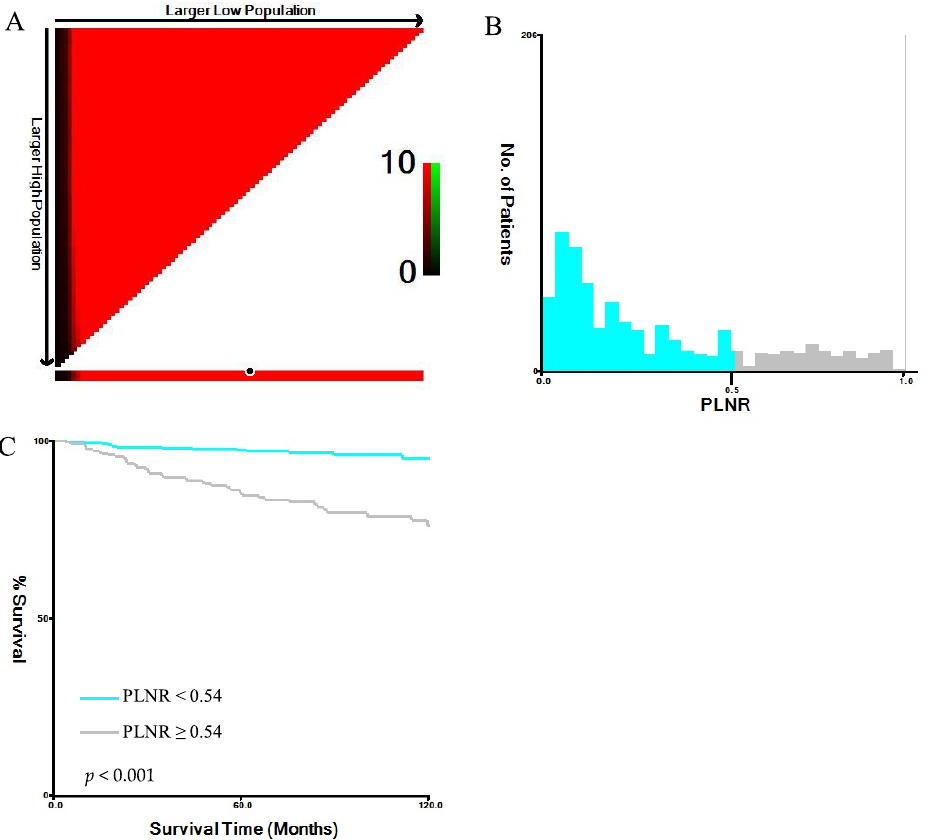
Figure 1. Optimal cut-off values for the PLNR. ( A ) The black dots represent the optimal cut-off values of the PLNR; ( B ) histograms of the number of patients grouped based on the optimal cut-off values of the PLNR; ( C ) Kaplan–Meier curves of patients in the PLNR < 0.54 group (blue) and the PLNR ≥ 0.54 group (grey). Abbreviation: PLNR, positive lymph node ratio.